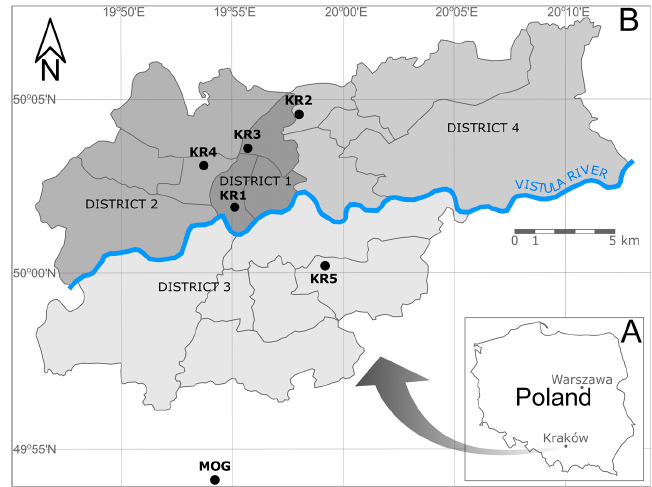
Figure 1. Sampling area: A—location of Kraków city at the map of Poland; B—sampling sites (KR1-KR5, Mogilany ( MOG)) on the map of Kraków (four main districts in the city are marked with different shades of grey).